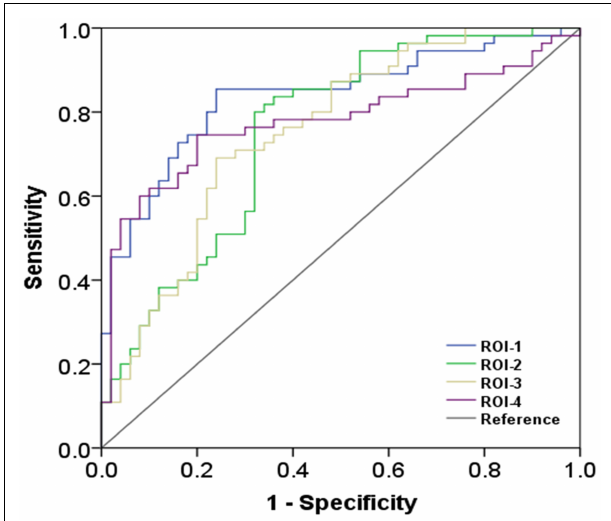
FIGURE 3 | The findings of receiver operating characteristic curve analysis. ROI-1 and ROI-3 are located in the left precentral and postcentral gyri; ROI-2 is located in the left middle frontal gyrus; and ROI-4 is located in the right precentral and postcentral gyri (the details on the ROIs are in Figure 2 and Table 2